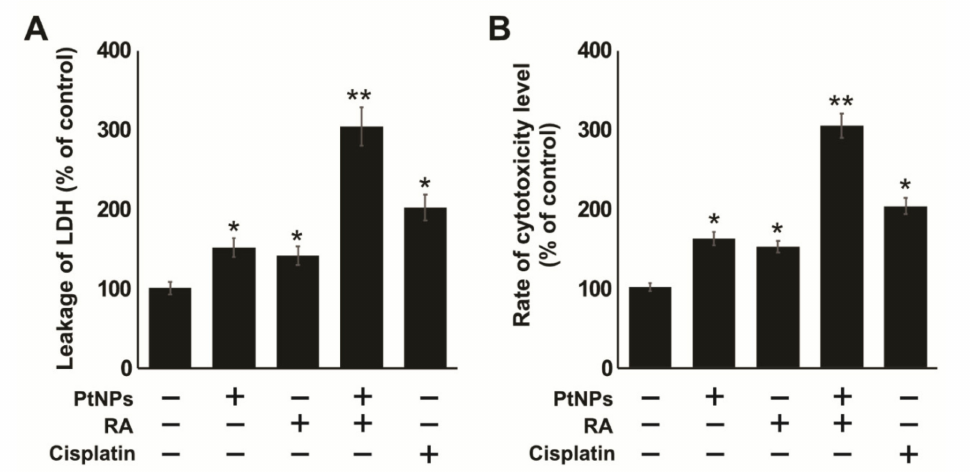
Figure 5. Combination of PtNPs and RA induces cytotoxicity in SH-SY5Y cells. SH-SY5Y cells were incubated with PtNPs (25 µ g / mL), RA (12.5 µ M), combination of PtNPs (25 µ g / mL) and RA (12.5 µ M), or cisplatin (6.5 µ M) for 24 h. Leakage of lactate dehydrogenase (LDH) was measured at 490 nm using the LDH cytotoxicity kit ( A ), and the level of dead-cell protease was determined by CytoTox-Glo cytotoxicity assay ( B ). The results are expressed as mean ± standard deviation of three independent experiments. The treated groups showed statistically significant di ff erences from the control group per the Student’s t -test; * p < 0.05 was considered significant, ** p < 0.01 was considered highly significant. PtNPs, platinum nanoparticles; RA, retinoic